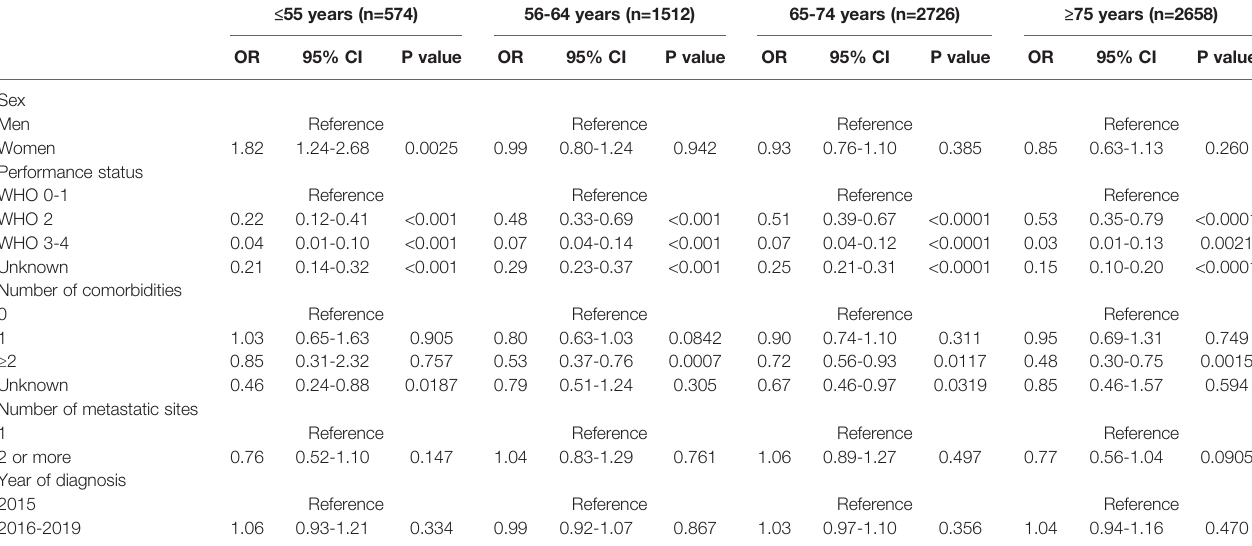
TABLE 3 | Multivariable logistic regression analyses for the probability of receiving systemic treatment in patients with metastatic pancreatic cancer strati fi ed by